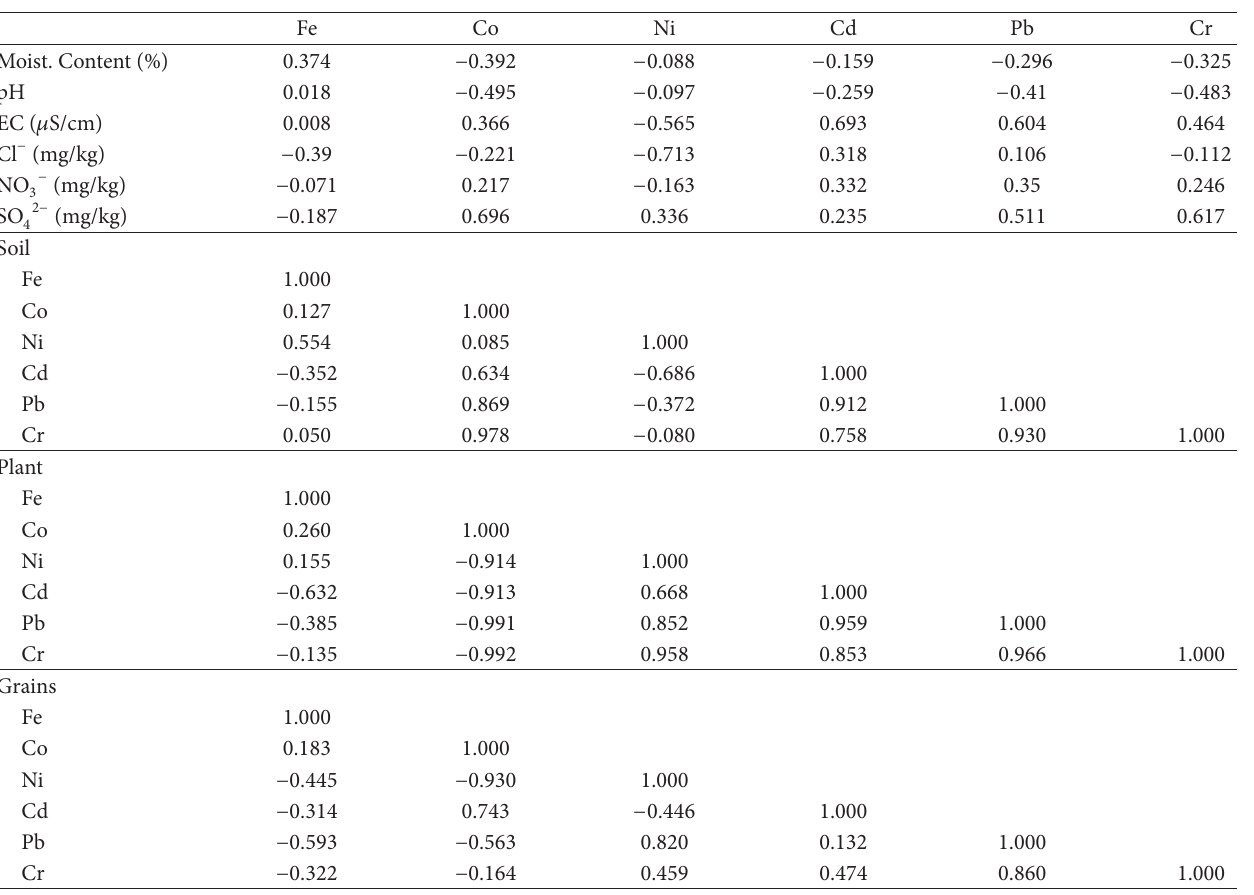
T 4: Correlation coefficient matrix for various parameters in respective soil, plants, and grain samples